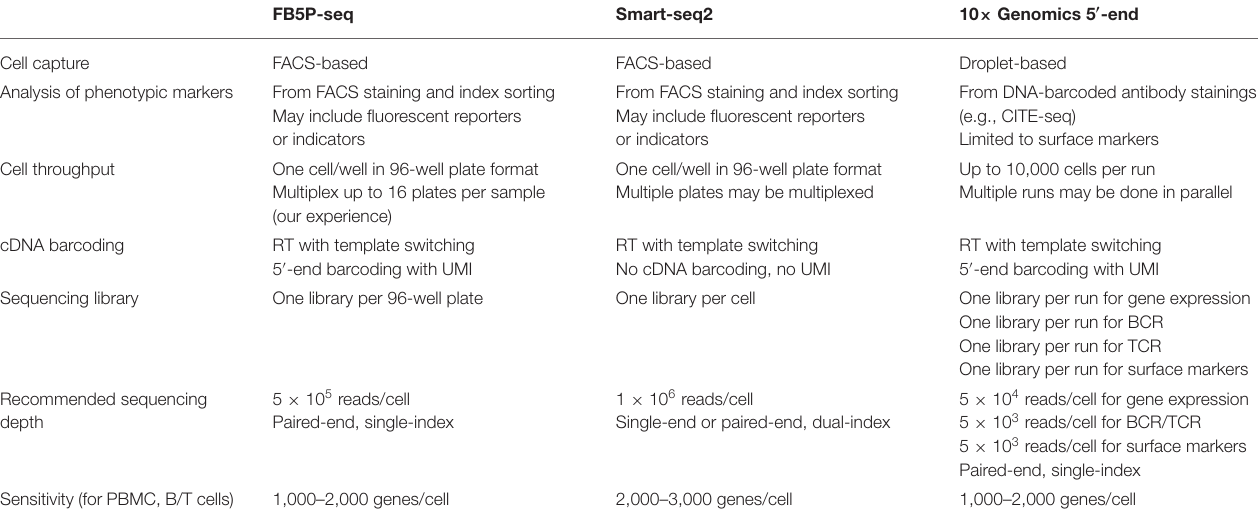
TABLE 1 | Key methodological features of FB5P-seq, Smart-seq2, and 10x Genomics 5 ′ -end integrative scRNA-seq methods.